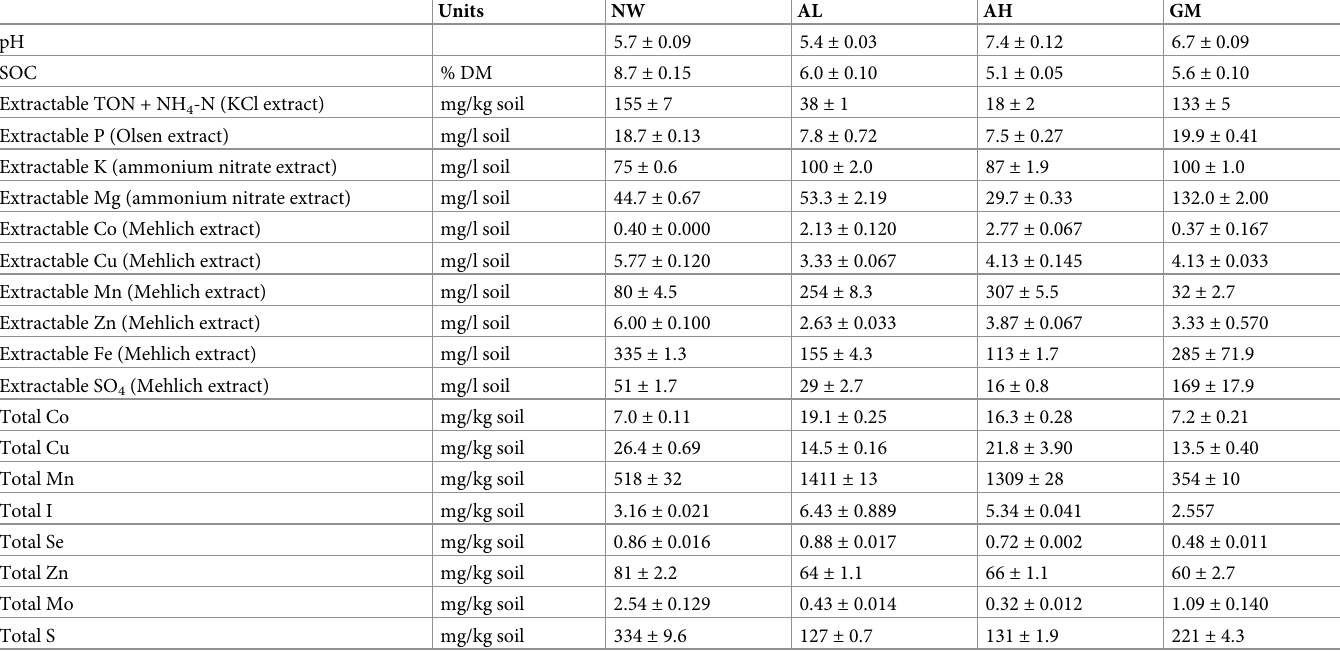
Table 1. Characterisation of the NW (North Wyke, grassland soil), AL (arable low pH), AH (arable high pH) and GM (growing medium) soils after nutrient